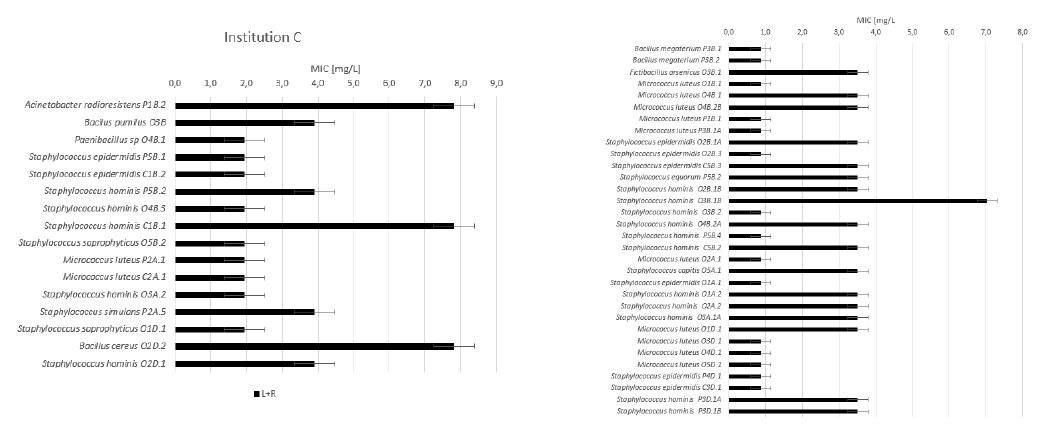
Figure 4. MIC values [mg/L] for QAC-based disinfectants L + R and Mikrozid for isolates in institutions (C) and (D). Legend: P—physiotherapy; O—occupational therapy; C—common area; B—before use; A—after use; and D—after disinfection. The first number is the number of the sampled device (Supplementary Material File S1), and the second number is the serial number of the isolate. For the QAC based disinfectants L + R and Mikrozid, the average MIC values in both institutions at all sampling occasions are 3.5 and 2.4 mg/L, respectively. The distinctive strains showing MIC values for L + R disinfectant at 7.8 mg/L were: